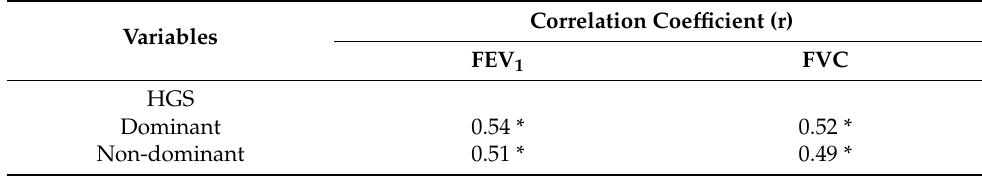
Table 2. The correlation coefficient between lung function indices and HGS.